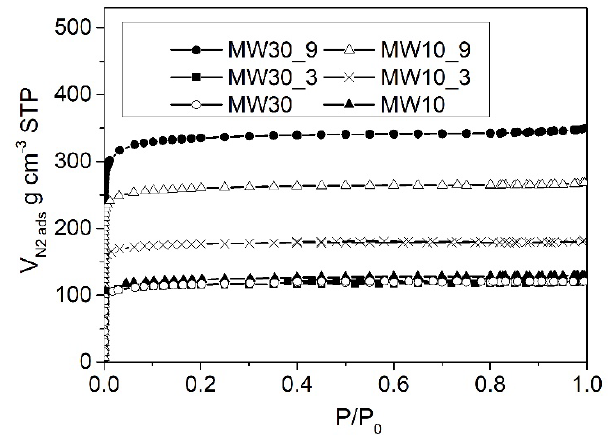
Figure 5. Nitrogen adsorption isotherms of selected carbon materials made from microcrystalline cellulose.